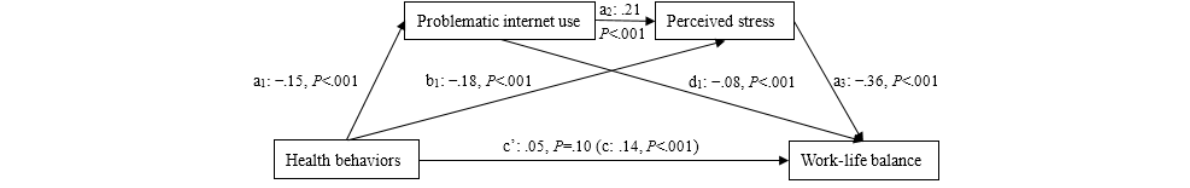
Figure 1. Serial mediation model and path coefficients predicting work-life balance. Path a 1 → a 2 → a 3 is the full serial mediation path (1). Path a 1 d 1 is the path from health behavior to work-life balance through problematic internet use. Path b 1 a 3 is the path from health behavior to work-life balance through perceived stress.